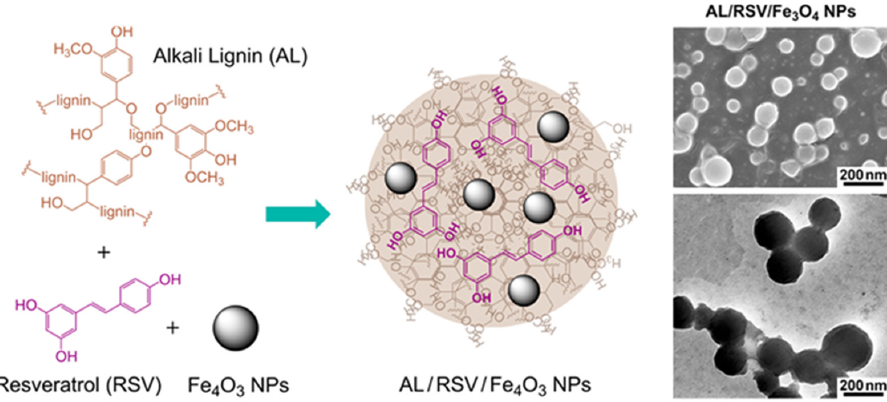
Figure 2. The preparation process, SEM, and TEM images of AL/RSV/Fe 3 O 4 . Reprinted with permission from Ref. [14]. Copyright 2017 American Chemical Society.